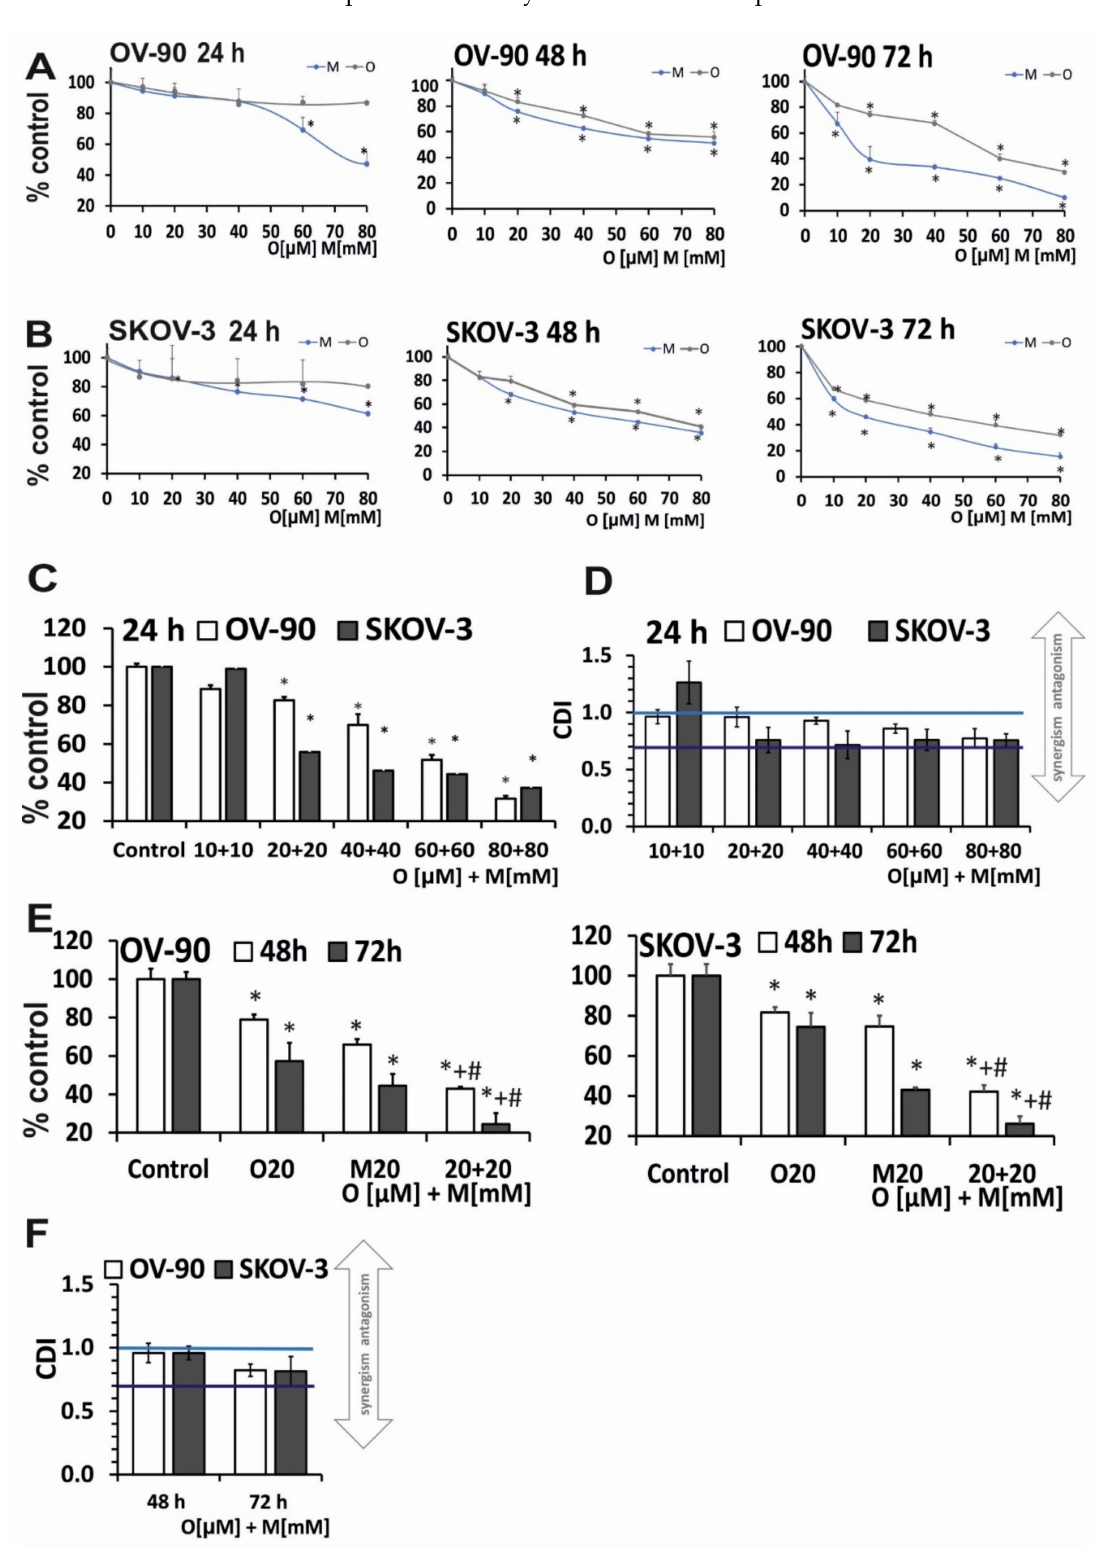
Figure 1. Metformin in combination with olaparib decreased cell viability more effectively than each single agent. ( A , B ) Cell viability after treatment for 24–72 h with olaparib (10–80 µ M) and metformin (10–80 mM) in OV-90 and